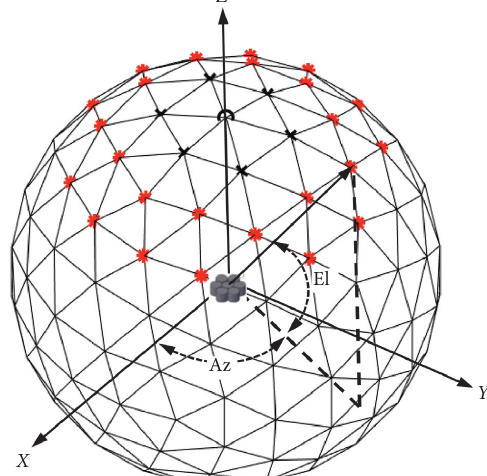
Figure 16: An example of a 2D-angle grid formed by an icosphere-based mesh; 7-element NSA phase-reference center and the icosphere center are collocated at the origin of the XYZ -coordinate system.